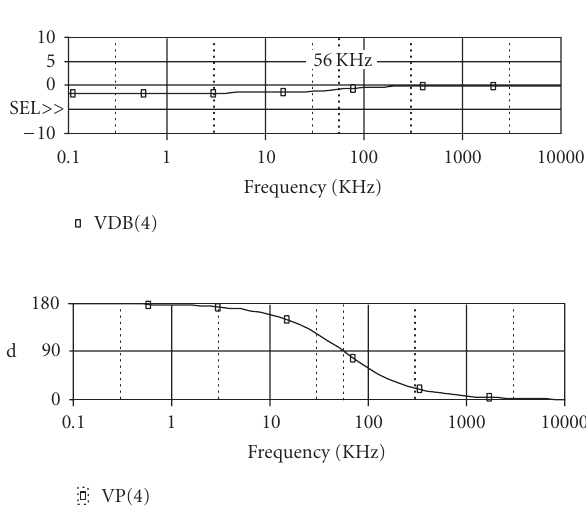
Figure 5: Frequency response of Circuit-1 using CCCDBA.